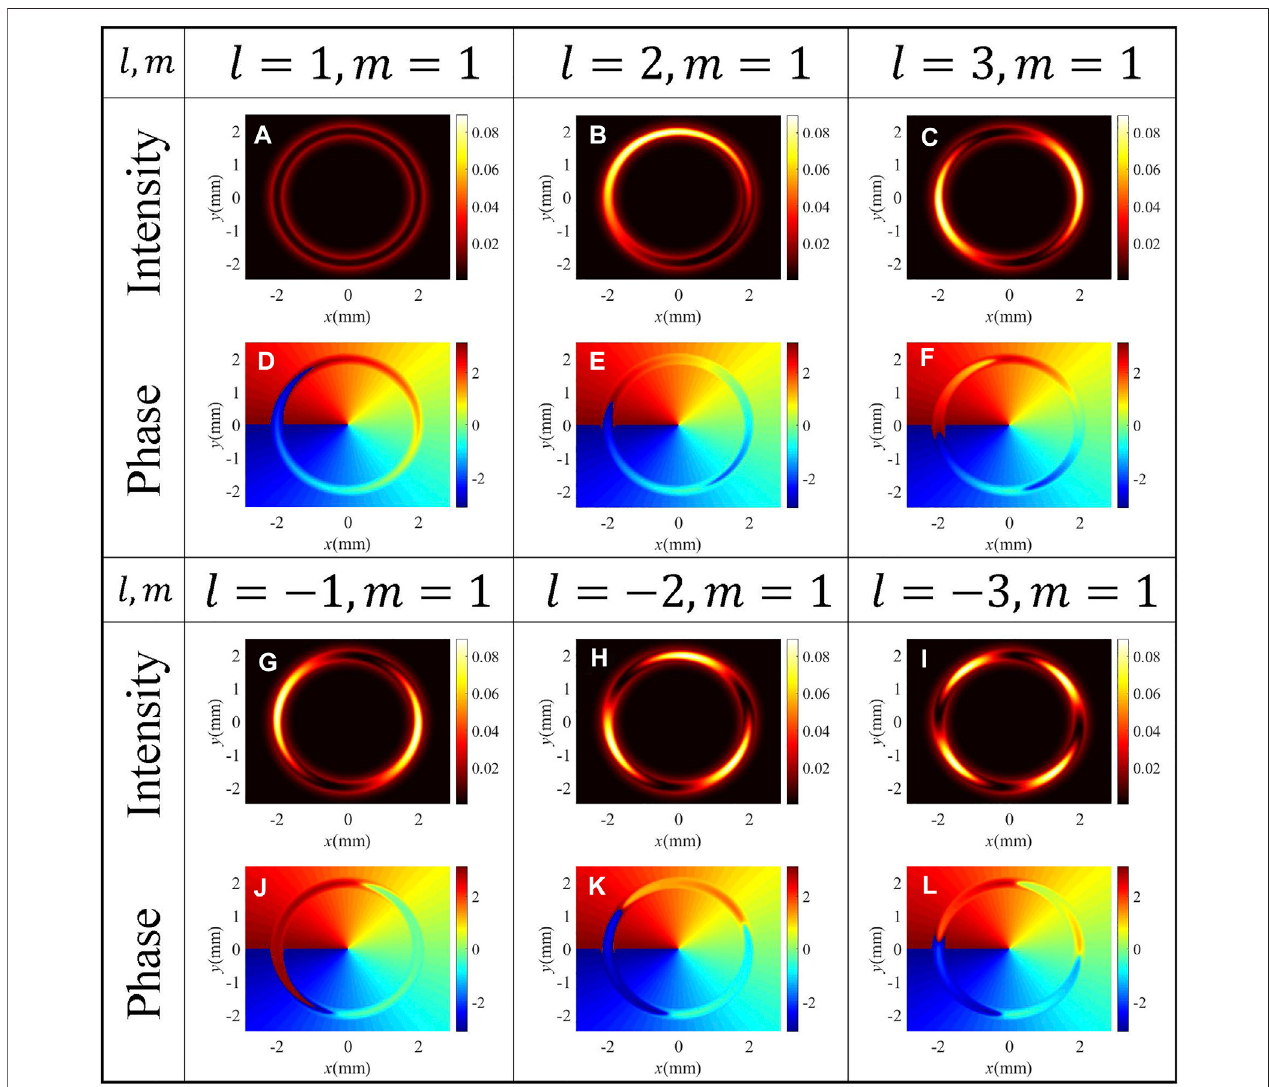
FIGURE9| Interferenceintensity[ (A – C) and (G – I) ]andphase[ (D – F) and (J – L) ]pro fi lesofdifferentvaluesofTCoftheFWM fi eld. Ω G 0 =0.16 meV, m =1,andother parameters are the same as in Figure 4C